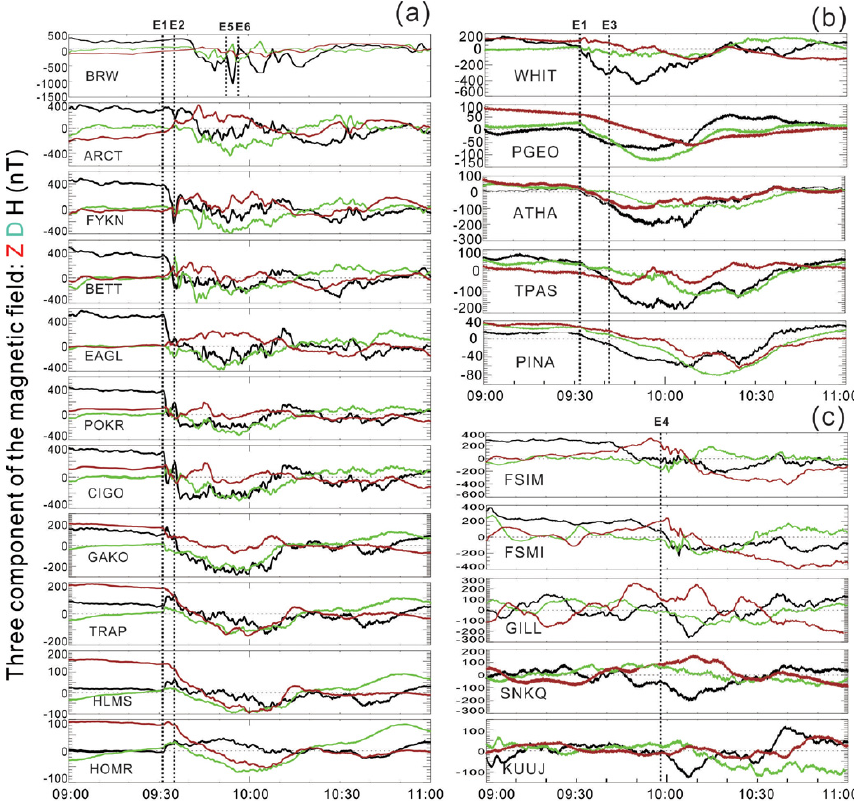
Fig. 4. The H-, D-, and Z- component magnetograms from selected THEMIS and Alaska magnetometers from 09:00 to 11:00UT on 5 De- cember 2008.